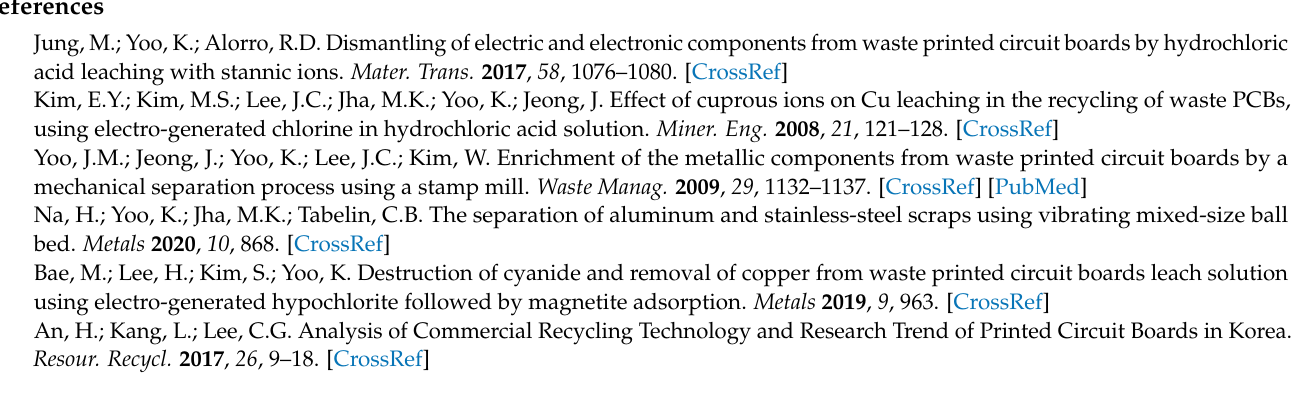
Figure 11. Arrhenius plot for Cu leaching in 1 mol/L sulfuric acid solution.